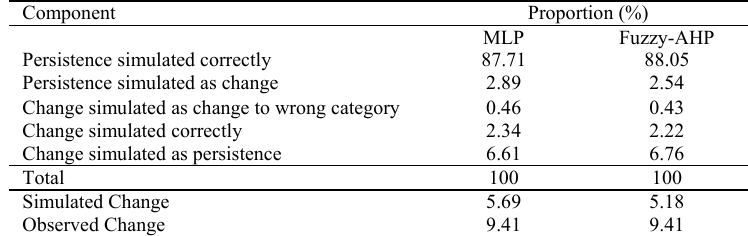
Table 7: Validation results for simulation of total landscape via three-dimensional technique